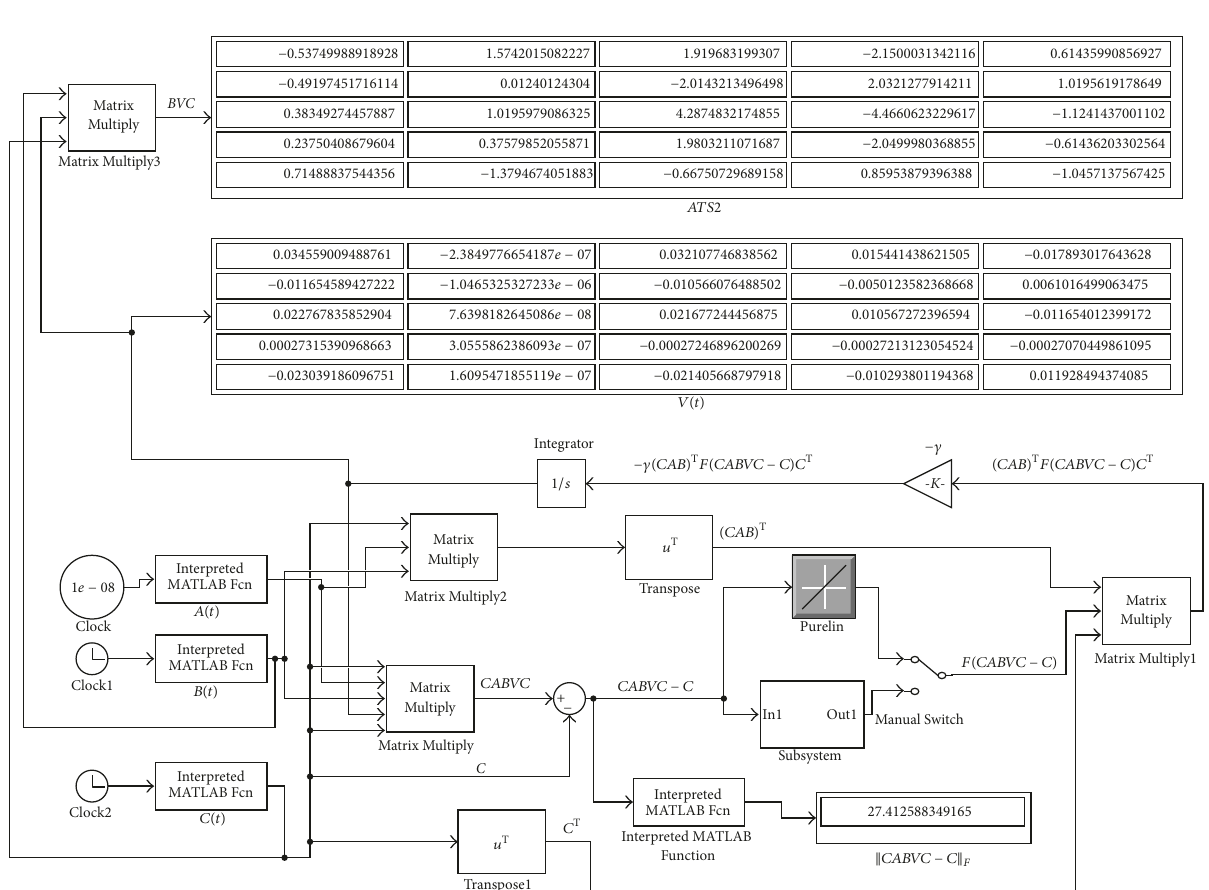
Figure 14: Dual implementation of Algorithm 3 when its conditions are not satisfied.